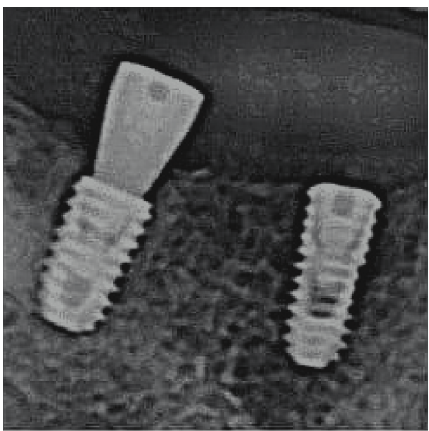
Figure 11: Subcrestal implant placement, intraoperative placement of the gingiva former.